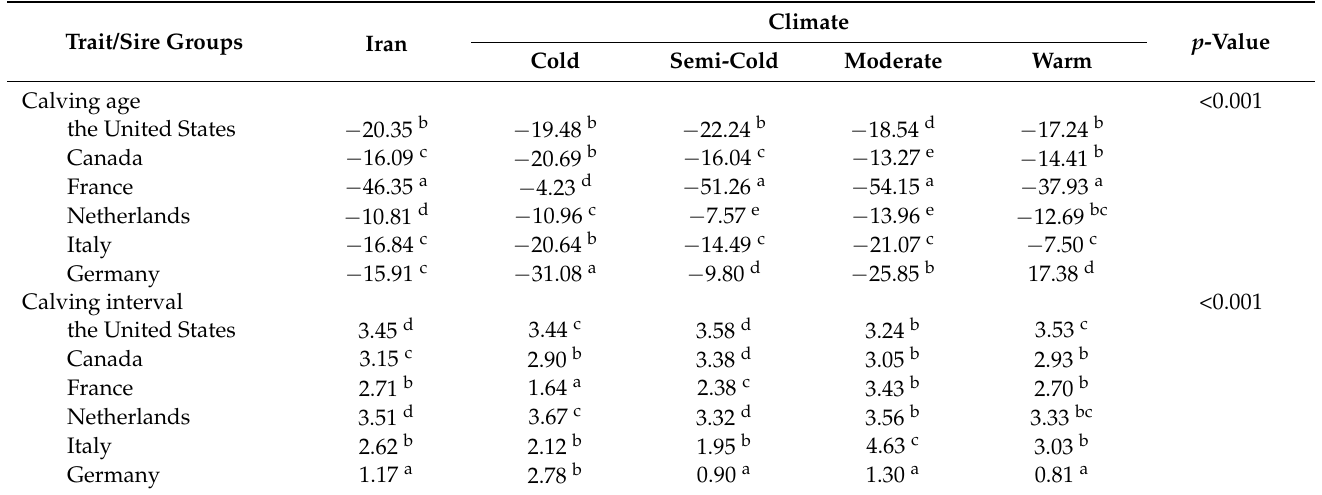
Table 4. Comparison of estimated breeding values (EBVs) for reproduction traits between daughters from different sire groups in Iran and its various climates